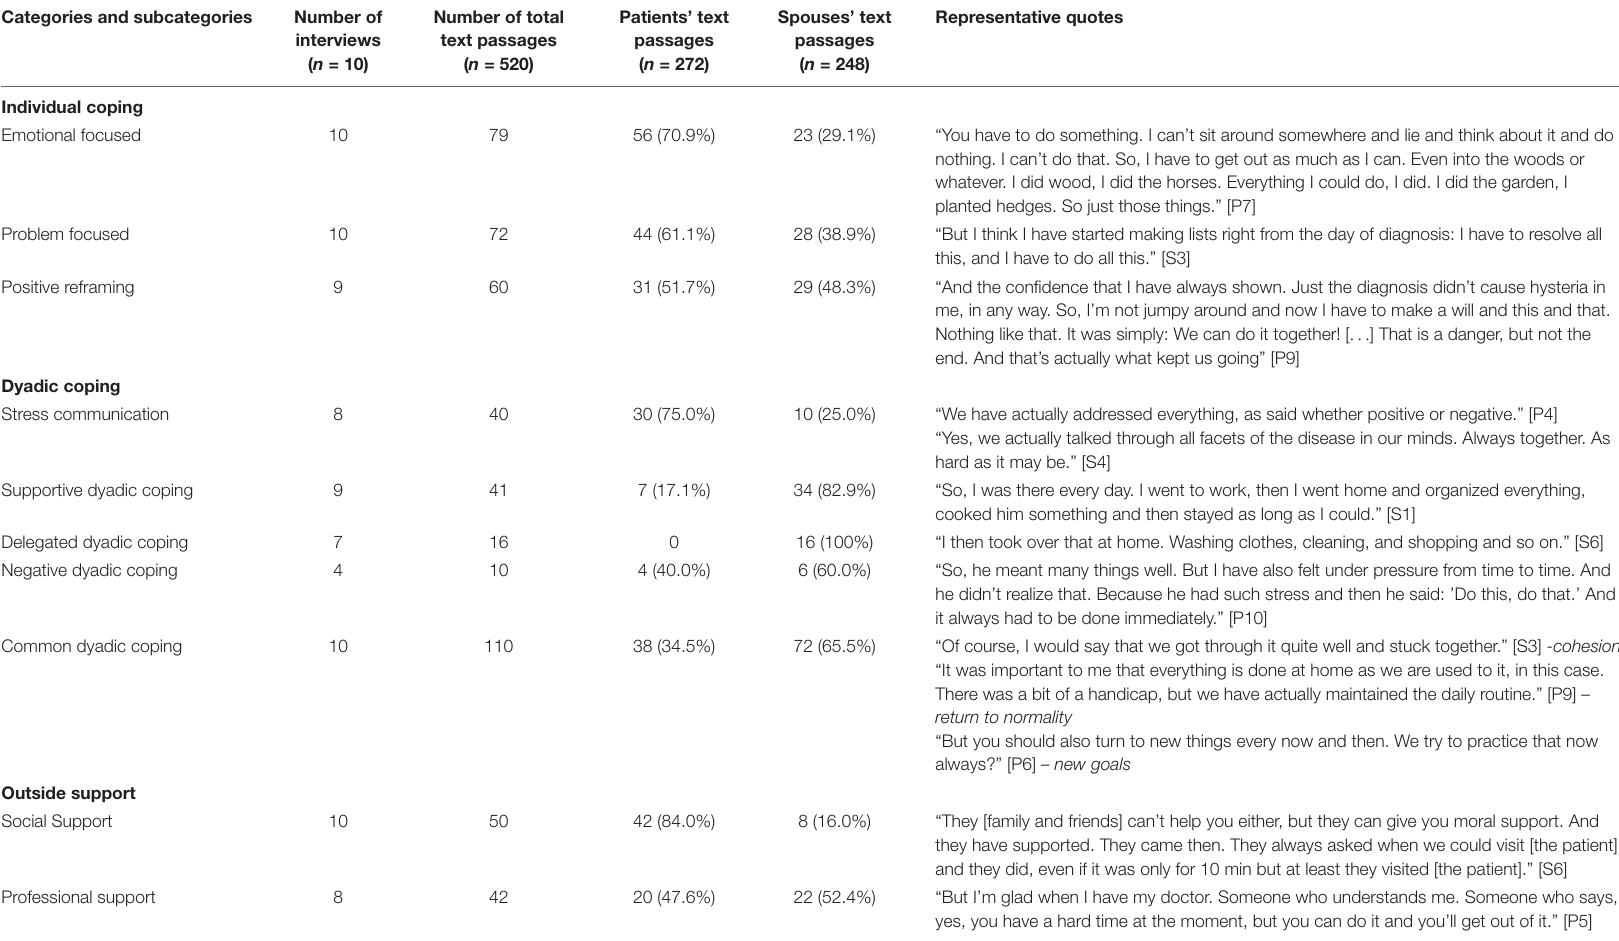
TABLE 2 | Patients’ and spouses’ quotes and frequency of categories identified. Categories and